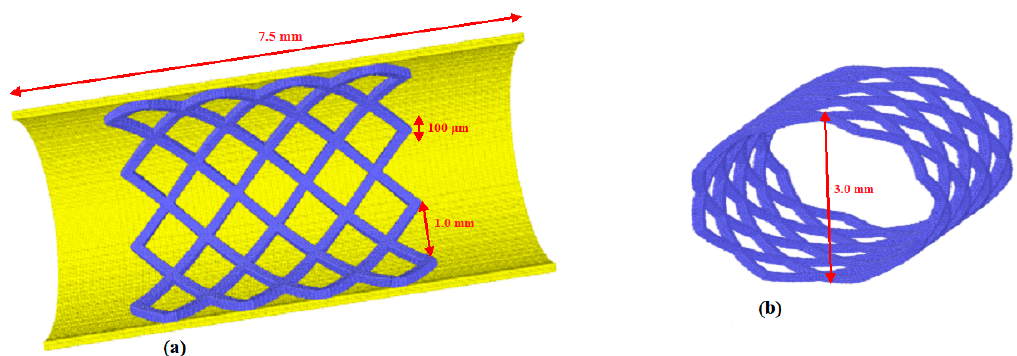
Figure 1. Illustration of the 3D stent geometry at ( a ) section view; and ( b ) front view showing complete stent. The flow is being driven by a sinusoidal (pulsatile) acceleration ( G ) of the flow in the axial direction to simulate a heartbeat of 60/min with a period ( T ) of 1 s; the same approach was used in a previous publication [29], where the reader can find more